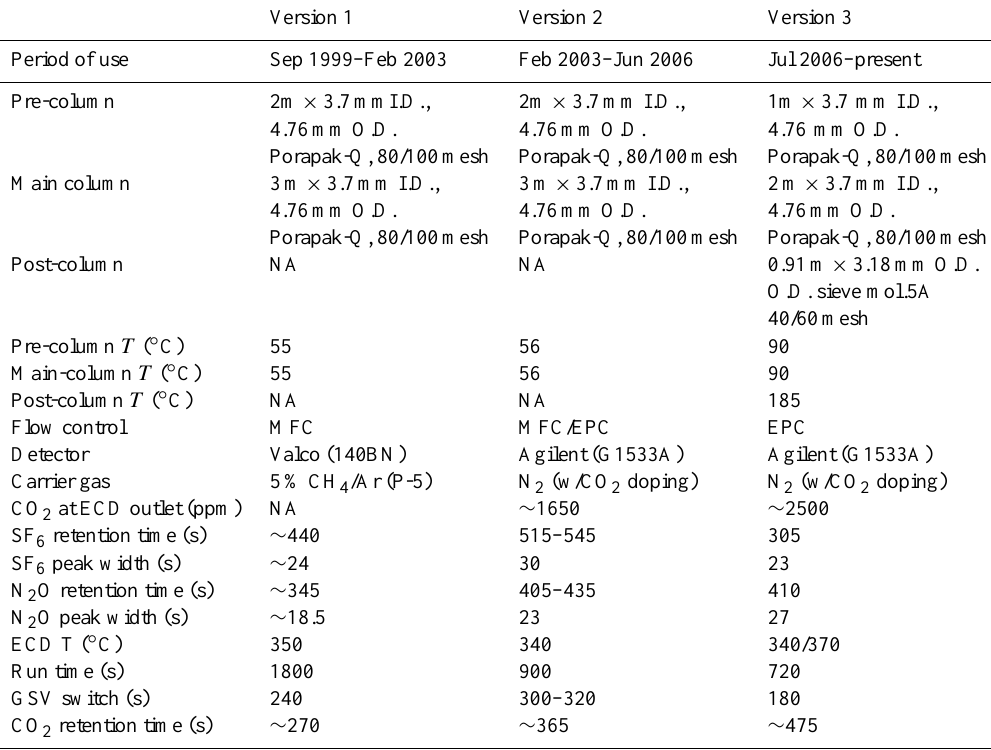
Table 1. Configuration of three SF 6 GCs used for calibration since